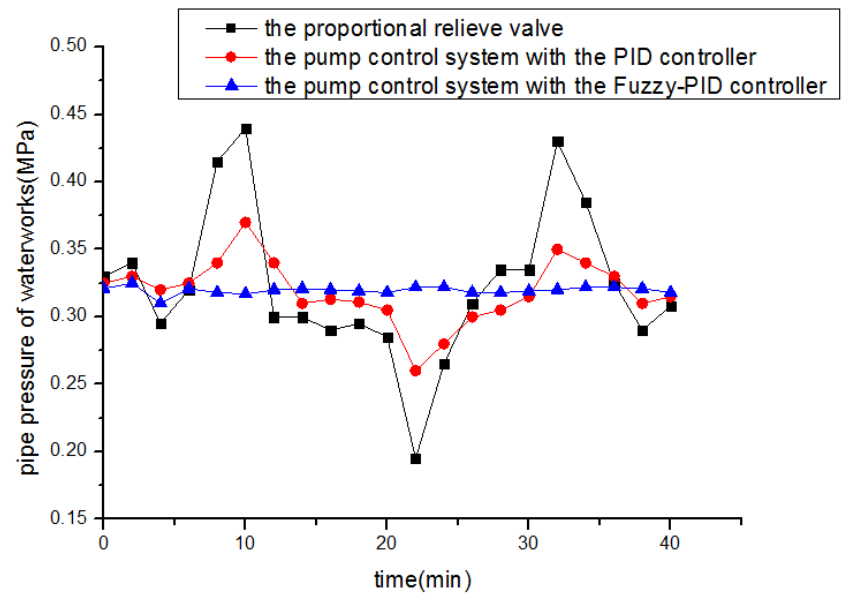
Figure 14. Pipe pressure fluctuation when transmission ratio = 0.92.